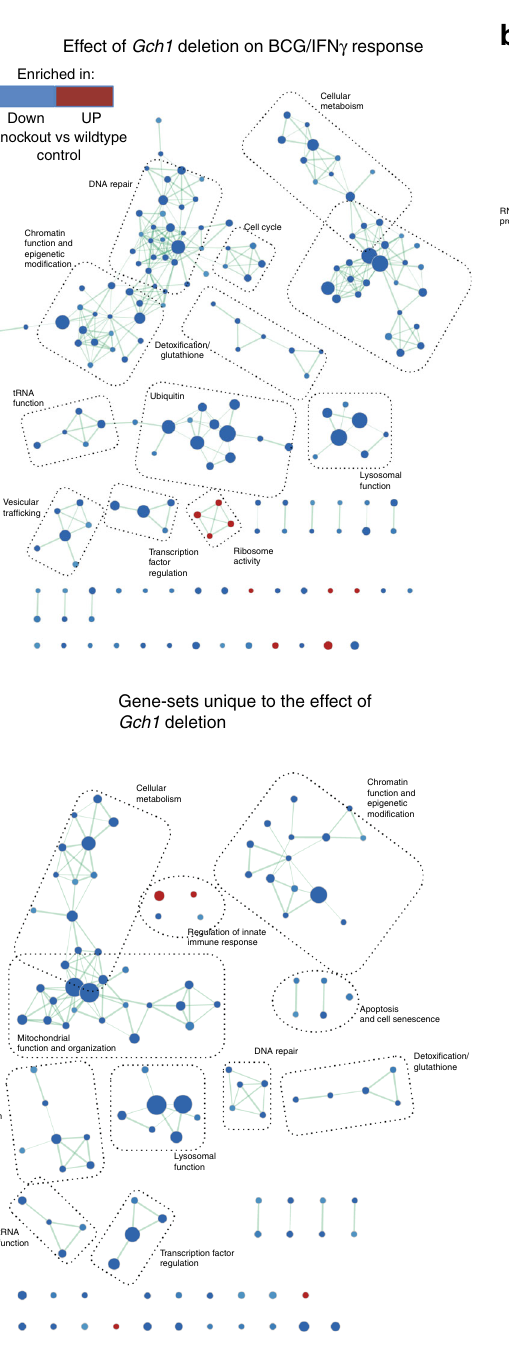
iNOS-independent BH4-dependent changes in macrophage biology have key translational relevance.